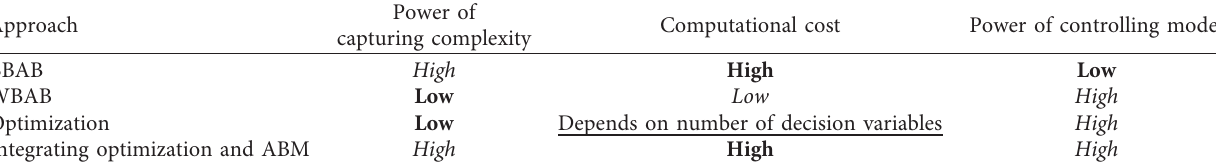
Table 4: Comparison of existing approaches for DM by